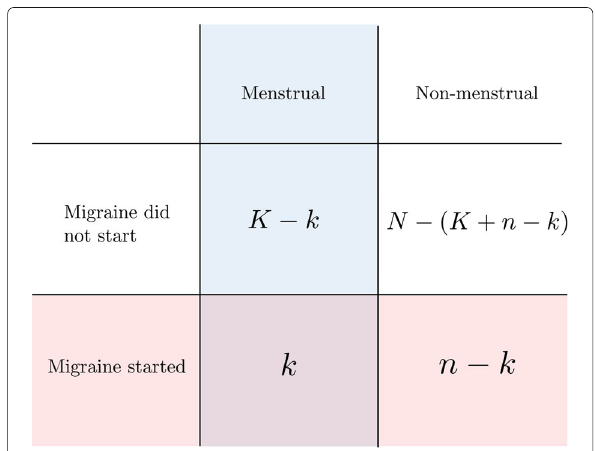
Fig. 3 The 2 × 2contingency table underlying the statistical test. All days on which a migraine could start is classified as within or outside the menstrual window, and, as having had an attack start or